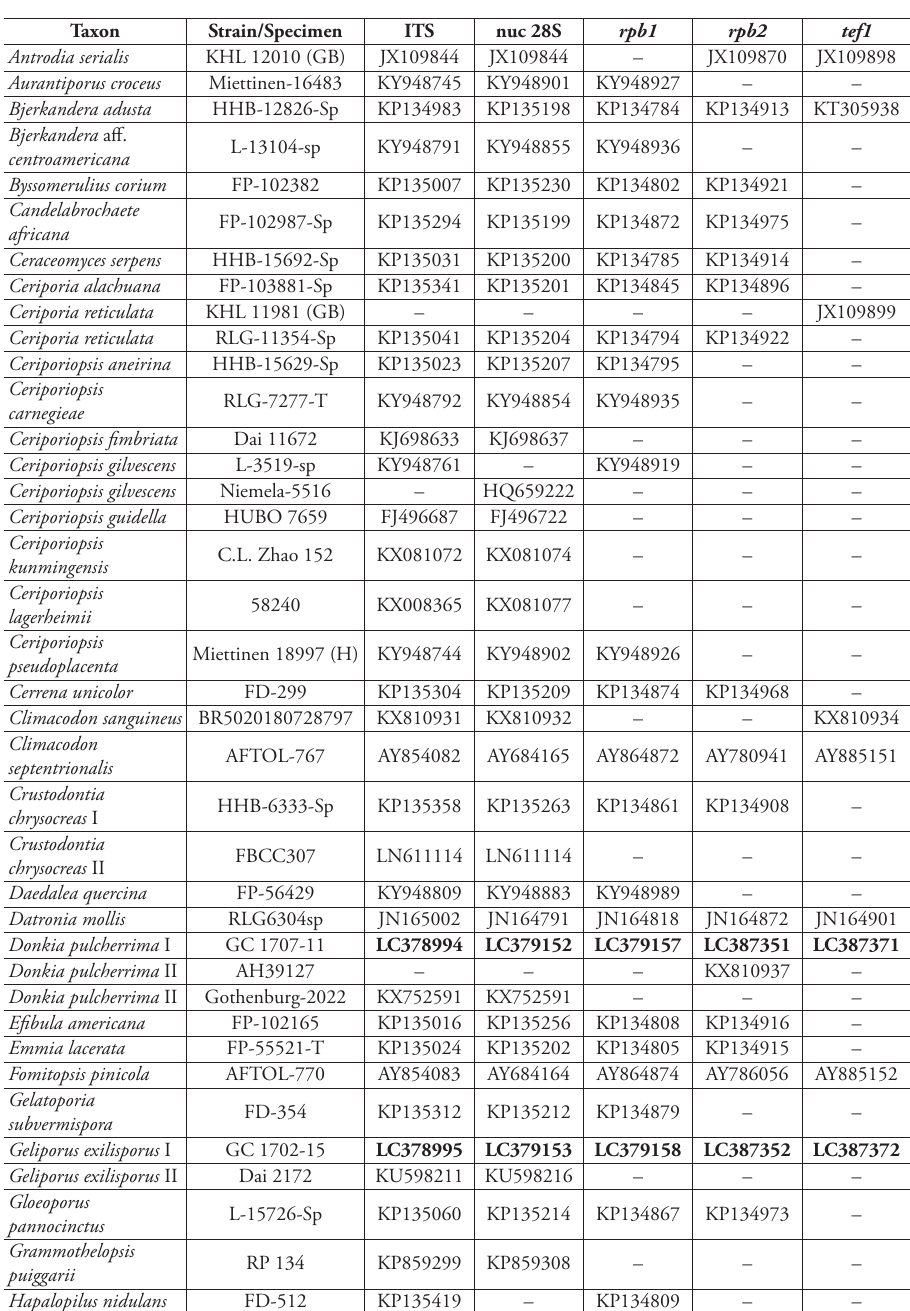
Table 1. Species and sequences used in the phylogenetic analyses. Newly generated se- quences are set in